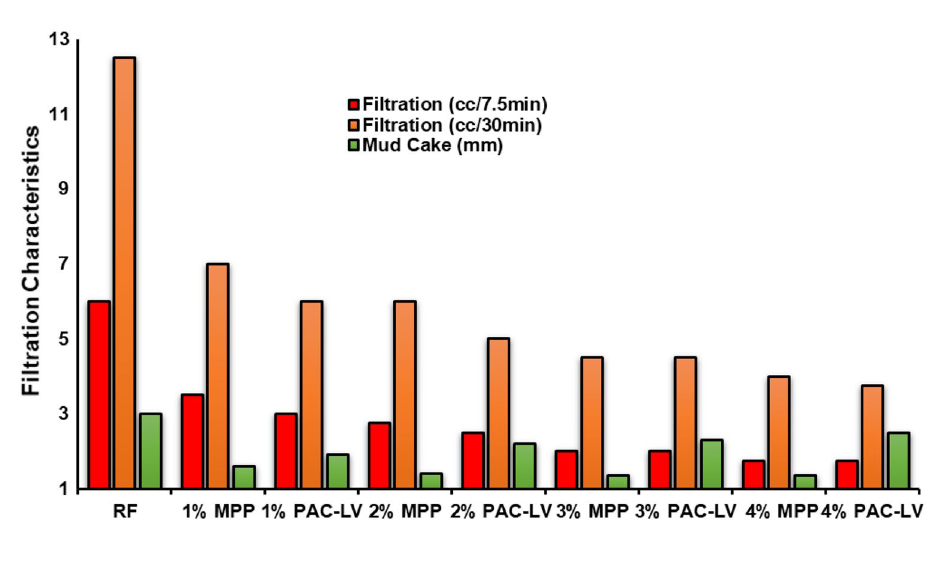
Fig. 12 The effect of MPP and PAC-LV on